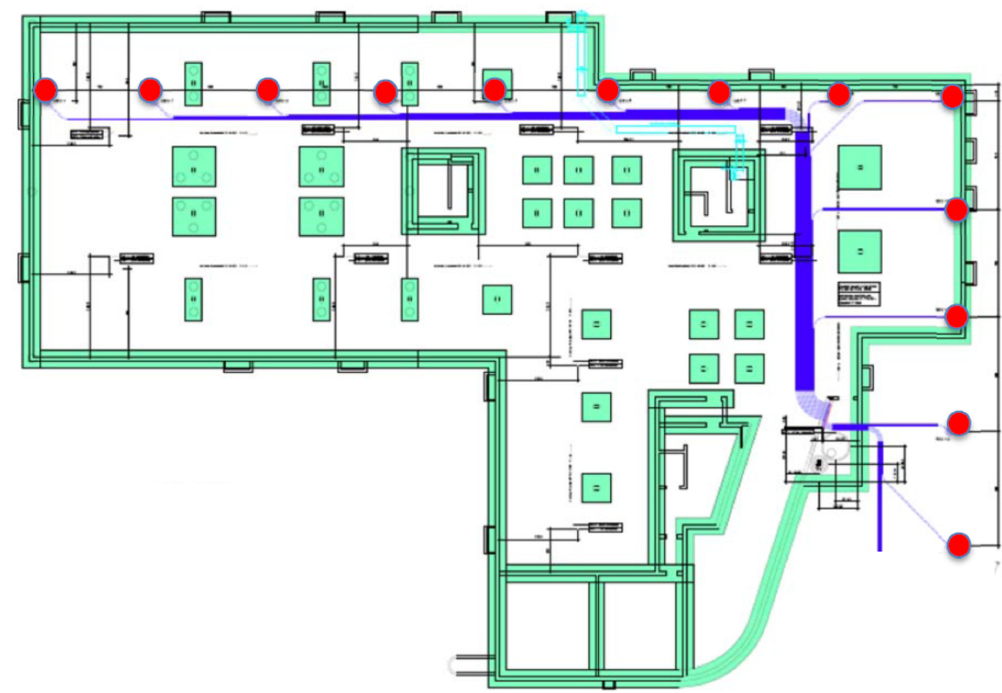
Figure 3. Position of 13 BHE under the building (source: [22]).